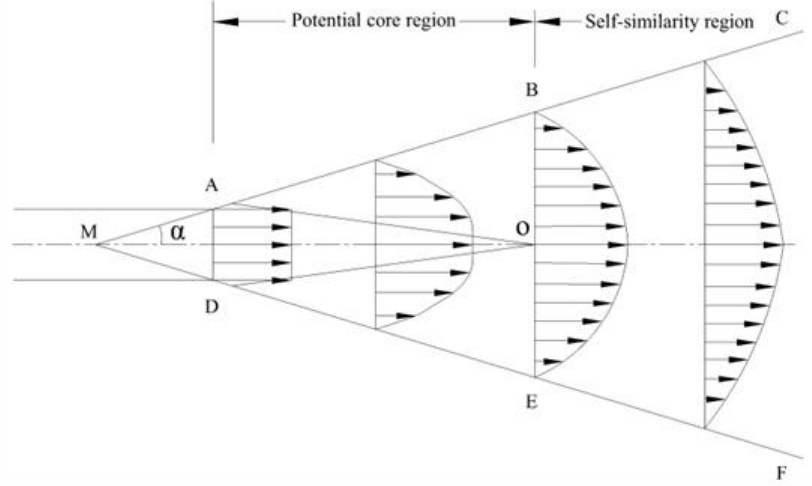
Figure 2. Schematic diagram of the changes in the gas flow stream. The distance of the potential core region S n is determined by Equation (1) [17].